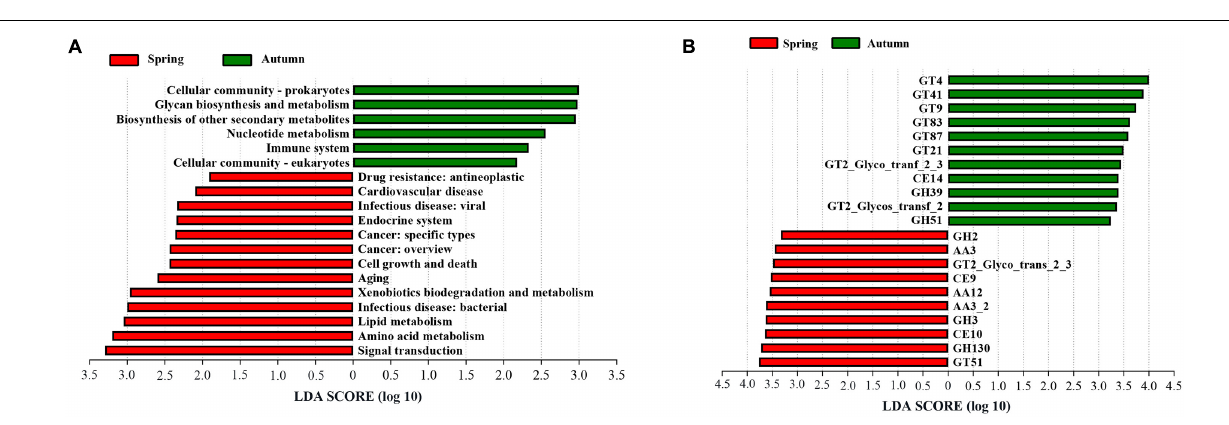
FIGURE 8 | Linear discriminant analysis (LDA) effect size (LEfSe) analysis of KEGG level 2 (A) and CAZy (B) between A. spanostachya in spring and autumn. GT, glycosyl transferases; CE, carbohydrate esterases; GH, glycoside hydrolases; AA, auxiliary activities. LDA >